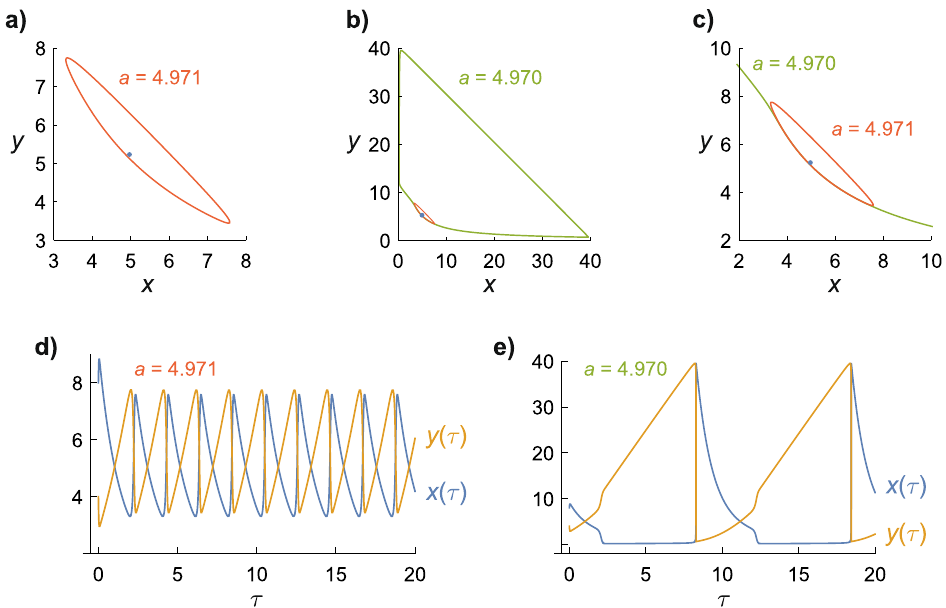
Figure 1. Oscillations in the concentrations of the Brusselator intermediates, x (τ) and y (τ) , shown as limit cycles ( a – c ) and explicit time-dependence ( d,e ). The values of a are as indicated; b = 26 in all five panels. The blue dot in ( a – c ) is the stationary-state solution for a = 4.971, b = 26. ( c ) is an expanded view of ( b ). The initial conditions are x (0) = 8, y (0) = 4. The limit cycles do not include the induction period ( τ < 5) required to establish stable oscillations.